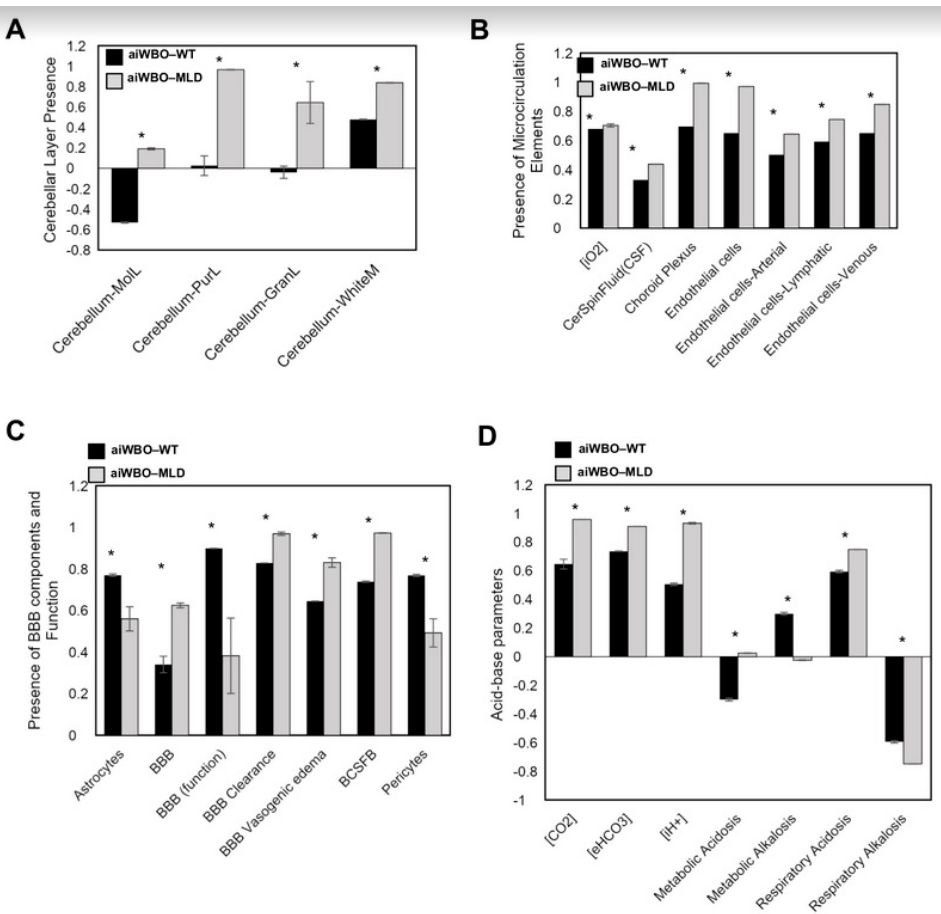
Figure 2. Simulation results for Cerebellar cortical layers microcirculation, BBB and Acid-Base status in aiWBO–WT vs aiWBO–MLD. ( A ), Comparison of cerebellar cortical layers in WT and MLD simulations. ( B ), Comparison of microcirculation elements in WT vs MLF simulations, ( C ), Comparison of blood brain barrier (BBB) concepts in WT vs MLD simulations, ( D ), Comparison of acid base concepts in WT vs MLD simulations. The vertical y-axes represent the semiquantitative levels of concepts that are estimated by DeepNEU relative to an arbitrary base line where 0 = base line, 1 = maximum expression or presence and − 1 = minimal expression level or presence. The horizontal x-axes represent the individual aiWBO concepts being simulated. Data represent means of three experiments ± 95% confidence interval. All p values from Mann-Whitney U test. * p < 0.01.